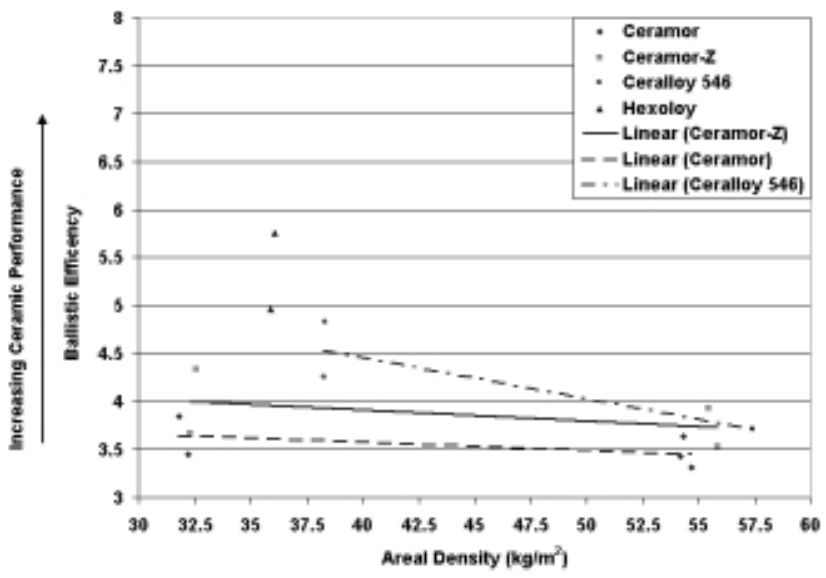
Fig. 6. Ballistic efficency vs. areal density for 750 m/s impact.